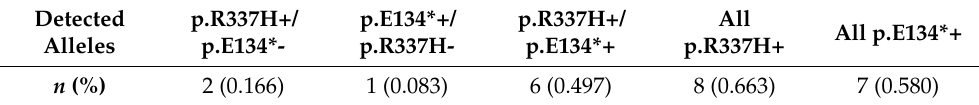
Table 5. TP53 p.R337H and XAF1 p.E134* variant allele frequencies in Group 3 ( n = 603).